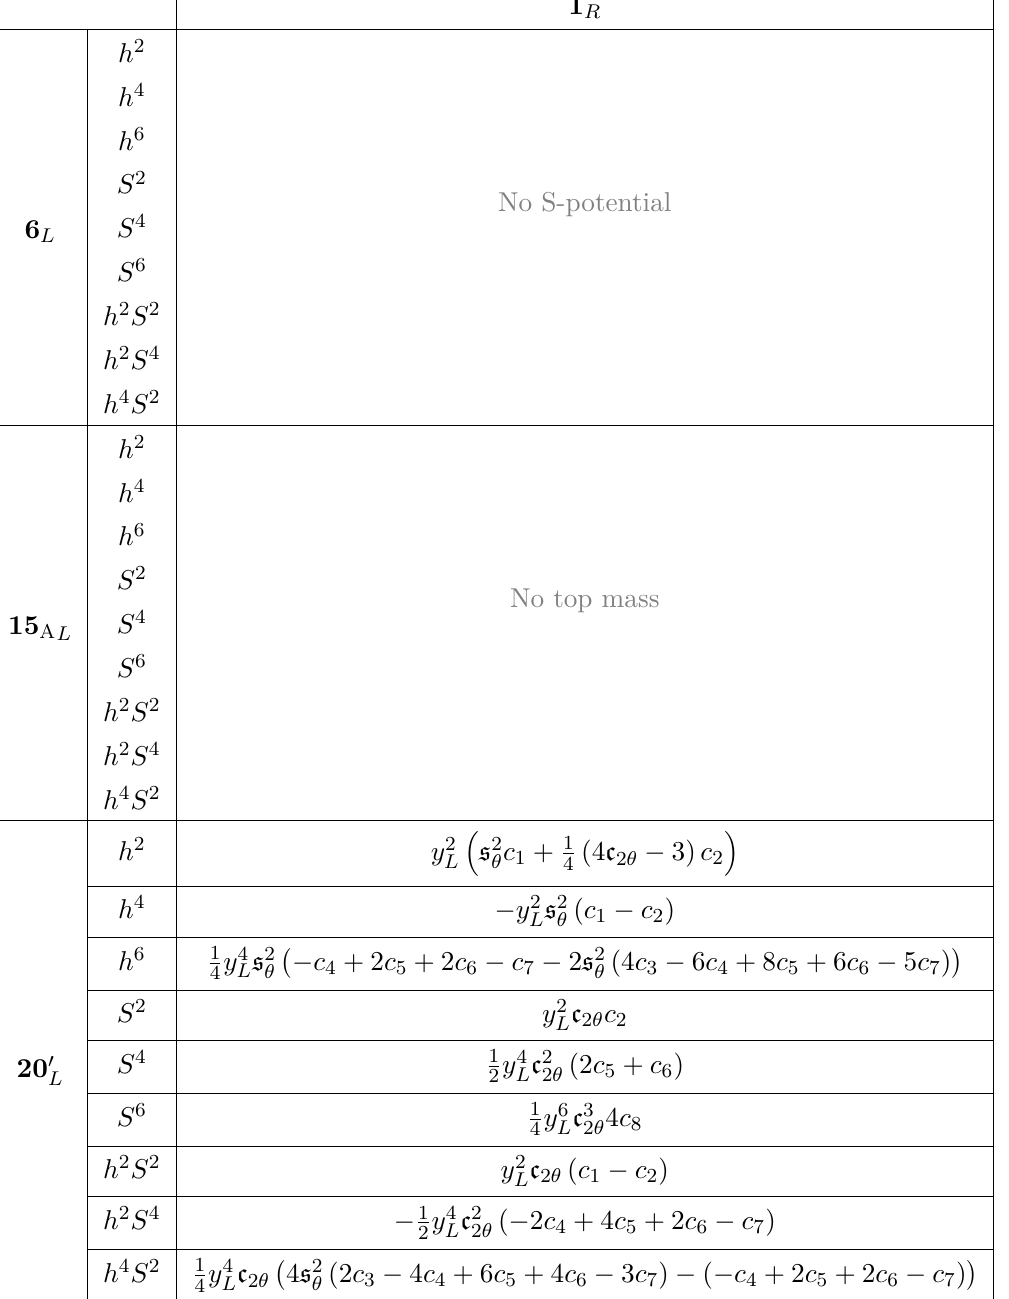
/ 16 π 2 , while every h or S comes with ∗ = sin 2 θ 20L θ